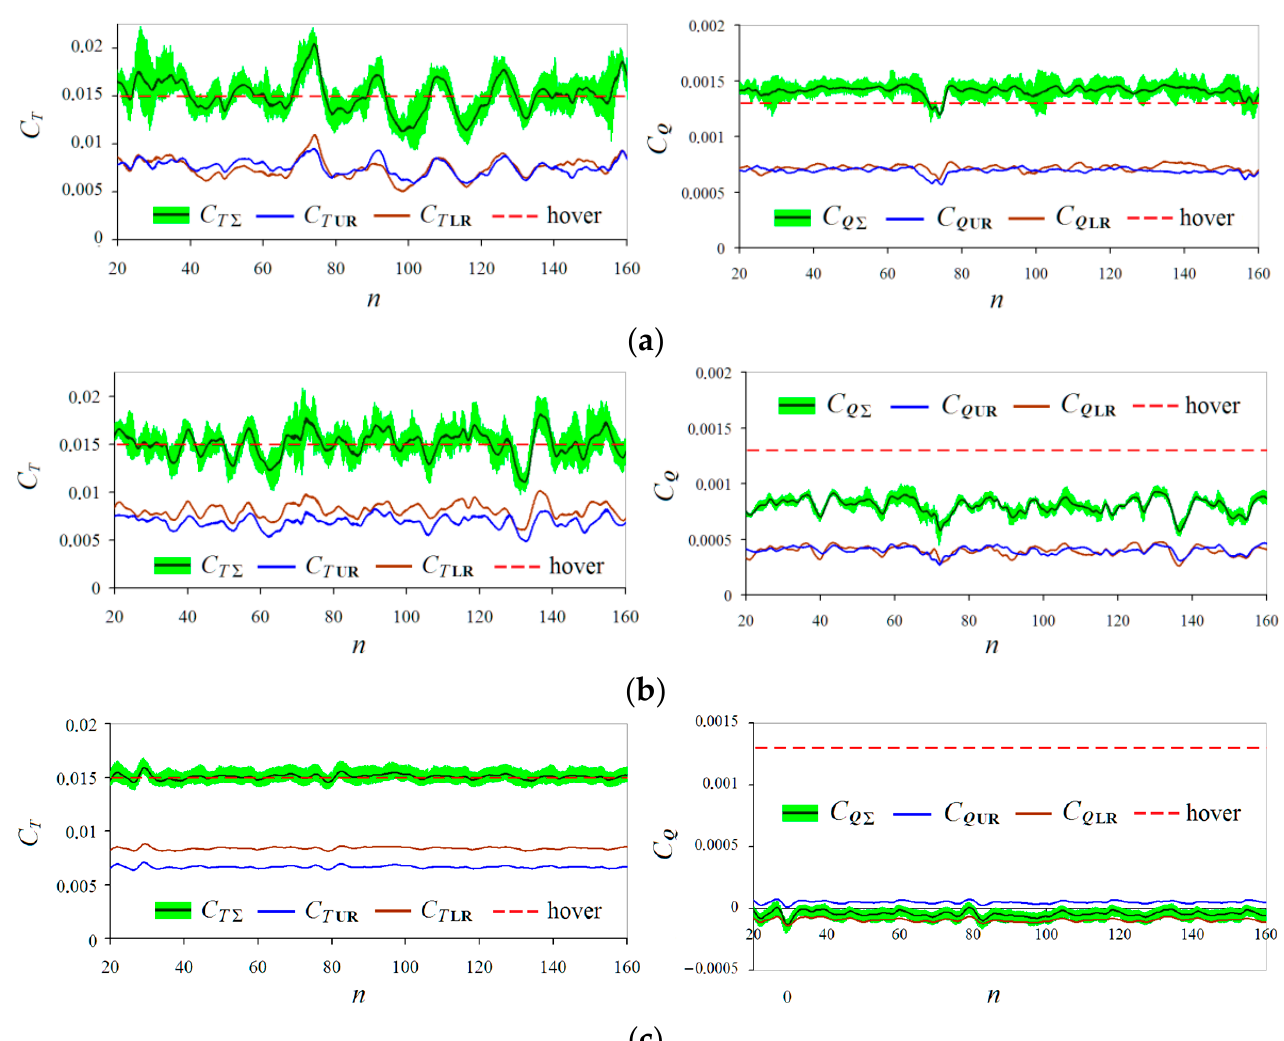
Figure 8. Diagrams of the dependence of the thrust C T = f(n) and torque C Q = f(n) coefficients vs. the number of revolutions of the rotor at α R = 70° for different vertical descent speeds: V y = 10 m/s ( a ); V y = 16 m/s ( b ); V y = 22 m/s ( c ).